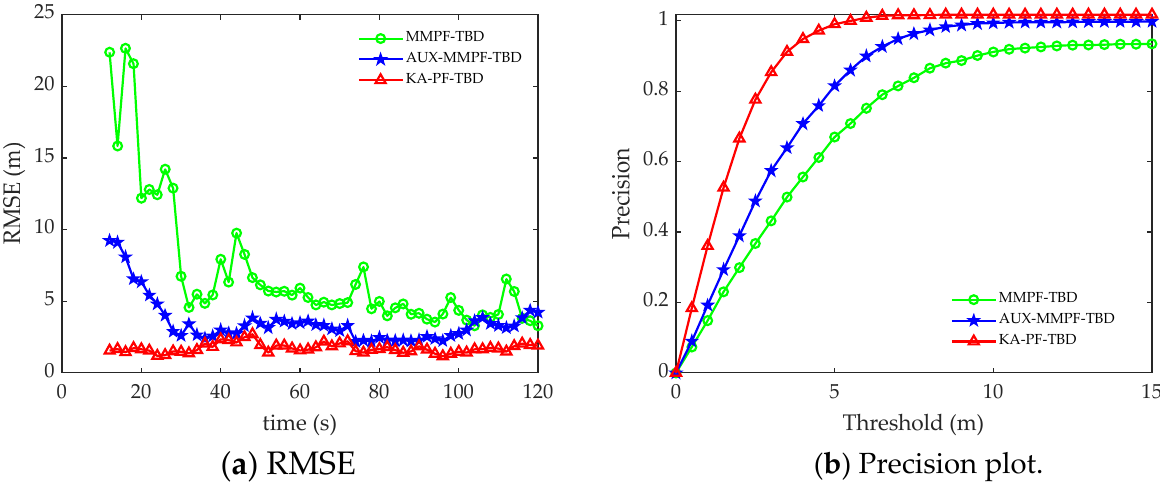
Figure 8. Simulation results. ( a ) The RMSE plotted against time. ( b ) Precision plotted against time.